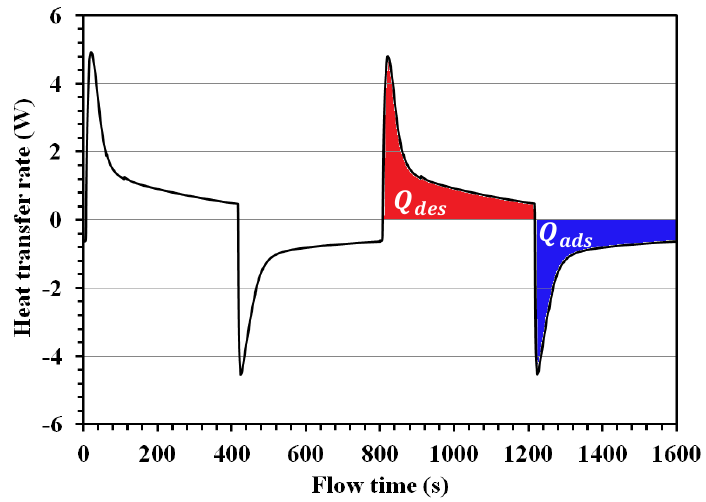
Figure 9. Simulated heat transfer rate to and from the finned tube adsorber. Energies 2018 , 11 , x FOR PEER REVIEW